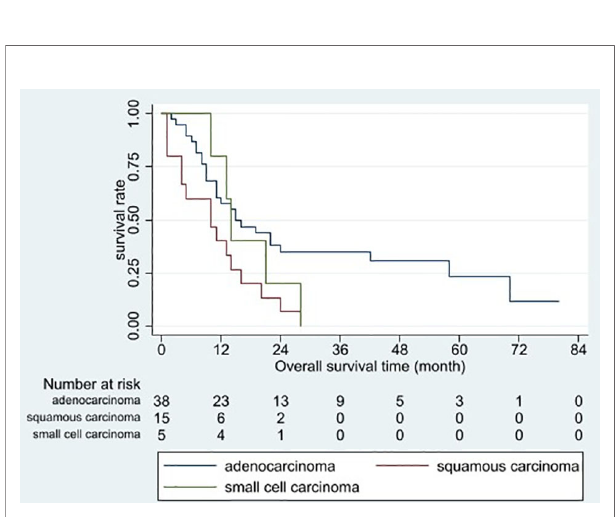
FIGURE 3 | Overall survival curves for different tumor sizes. Patients with a tumor ≤ 3 cm had better overall survival than those with a tumor >3 cm (p = 0.017).